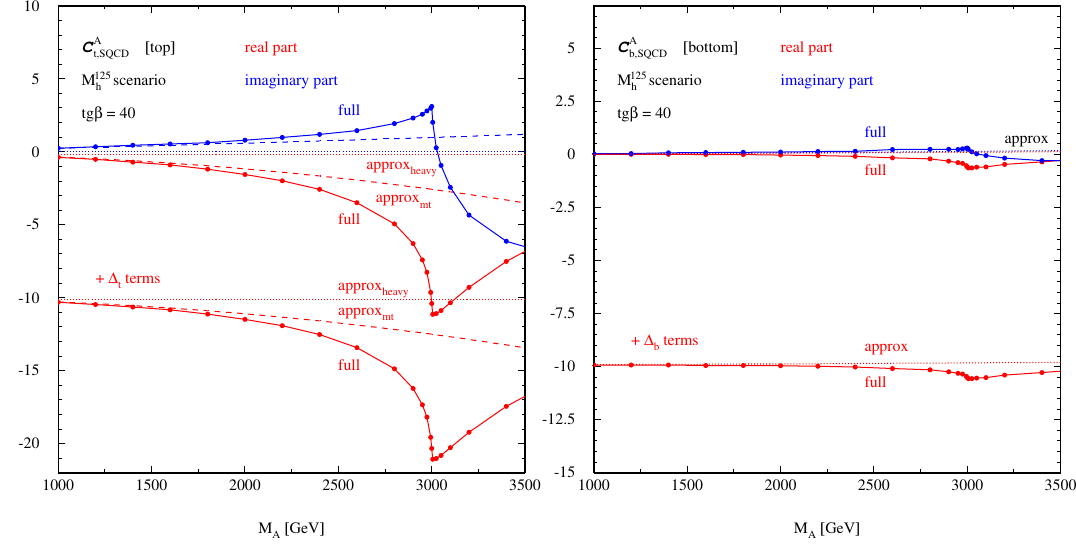
Figure 7 . The same as figure 6, but for tg β = 40